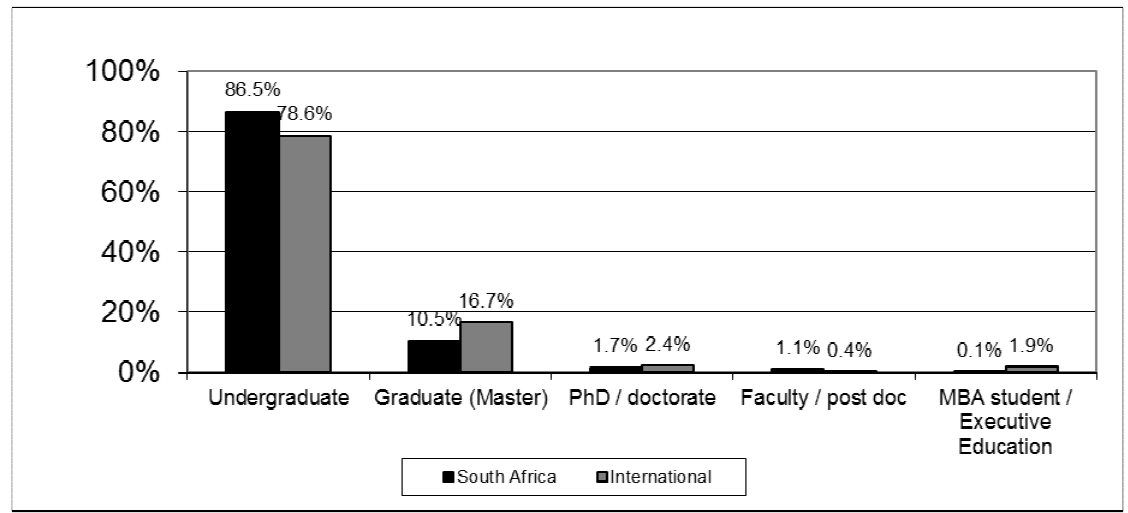
Figure 1: Study level profile of South African and international students The majority of South African students (71.3%) were enrolled for qualifications at business and economic sciences faculties, specialising in management/business administration, economics and accounting/financial accounting/internal auditing. Twenty per cent of students studied towards degrees in the natural sciences with the remainder enrolled for qualifications in the social